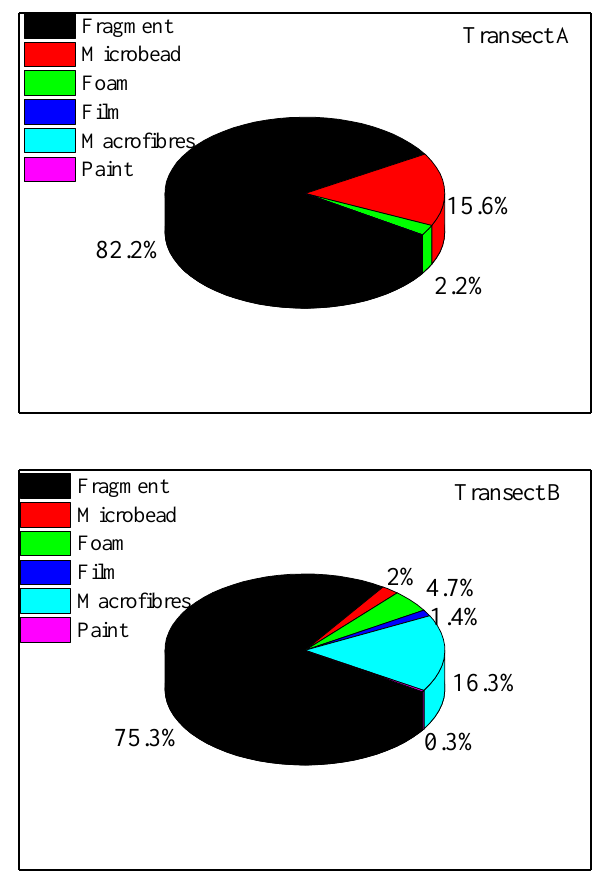
Figure 6. Composition by plastic debris shape along the land-based source wastewater discharge outlet.